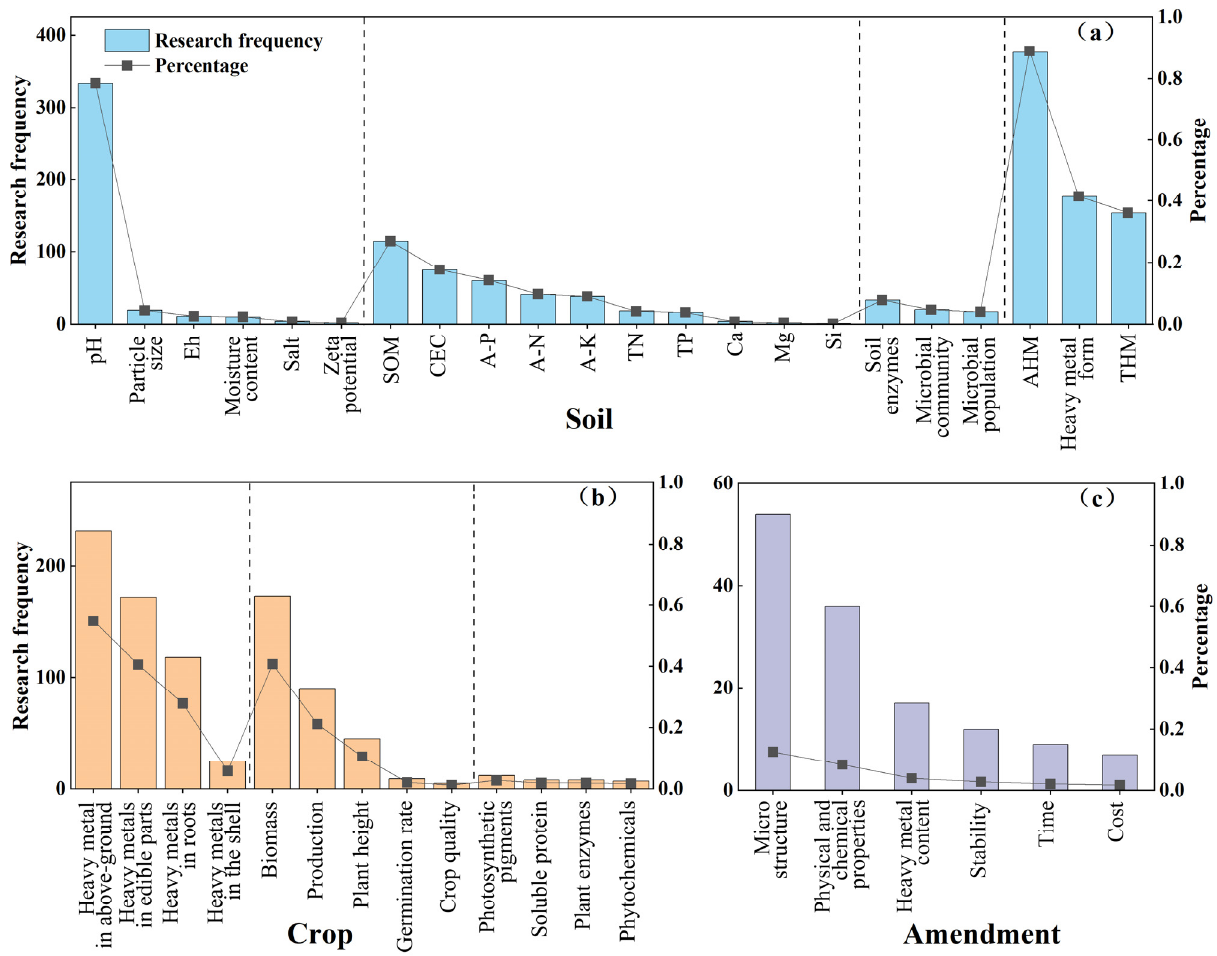
Figure 2. Extract of evaluation indicator of stabilization effect: ( a ) soil indicators, ( b ) crop indicators, ( c ) amendment indicators.